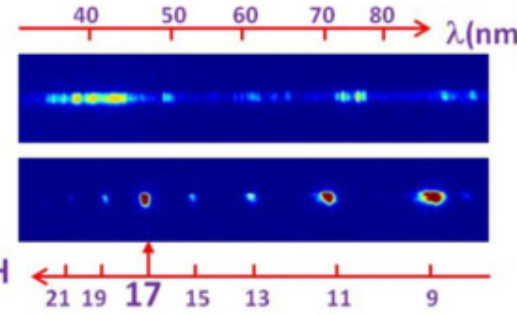
Figure 2. Raw images of plasma (upper panel) and harmonic (bottom panel) emission spectra. Upper and bottom lines show the calibrated wavelength (in nm) and harmonic axes,